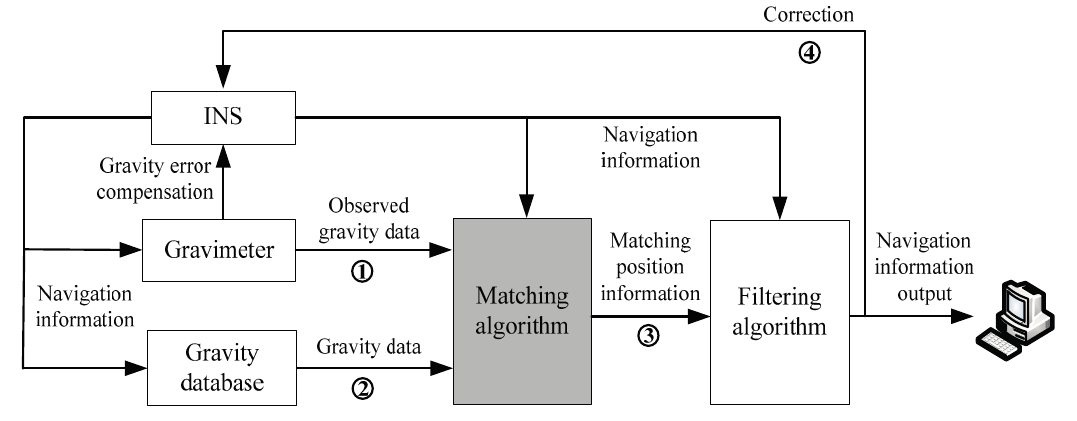
Figure 1. Schematic diagram of gravity